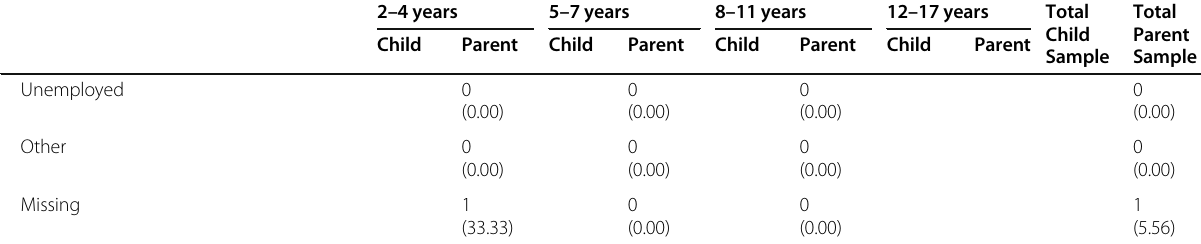
Table 1 Demographic Characteristics of Children and Parent Participants a